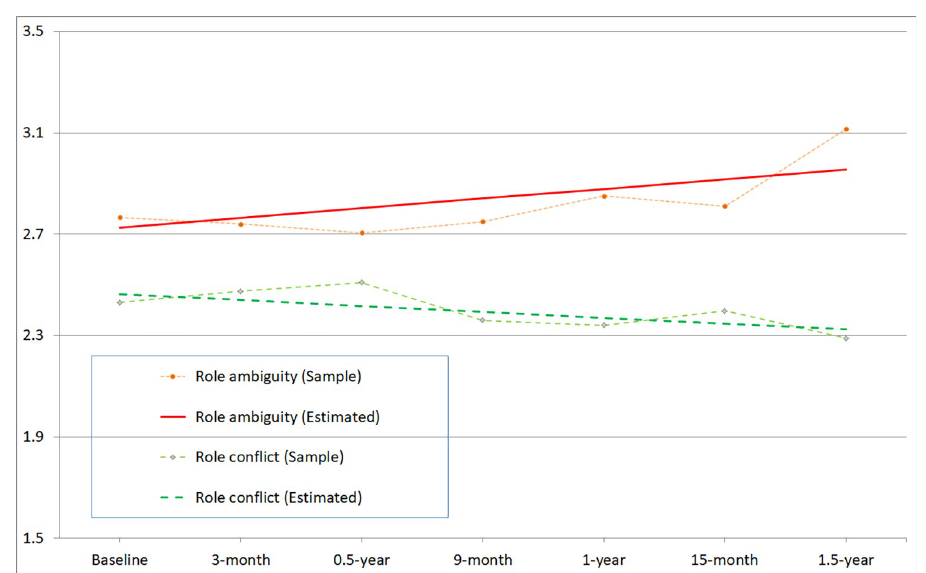
Fig 1. Developmental trajectories of role ambiguity and role conflict in the child care workers.